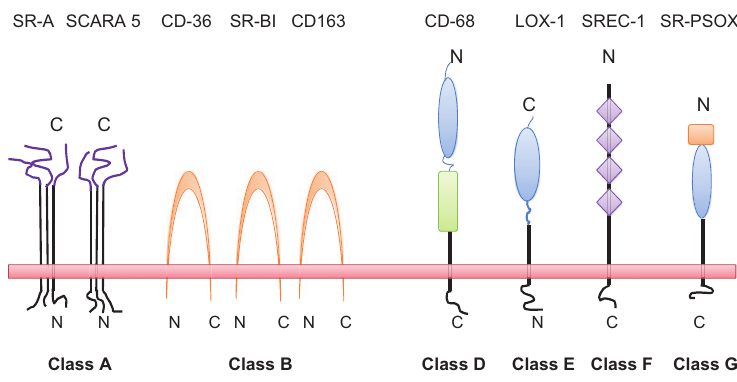
Figure 1 A schematic showing the major SRs.